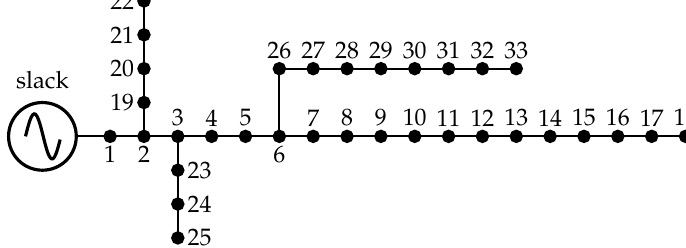
Figure 2. IEEE radial 33-node test system.